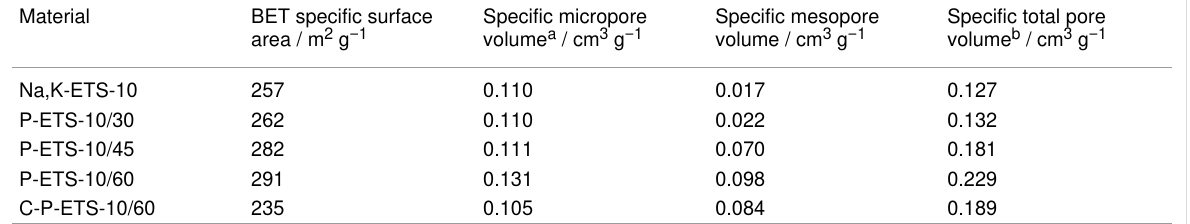
Table 1: Textural characteristics of the titanosilicates from the results of the N 2 sorption experiments.